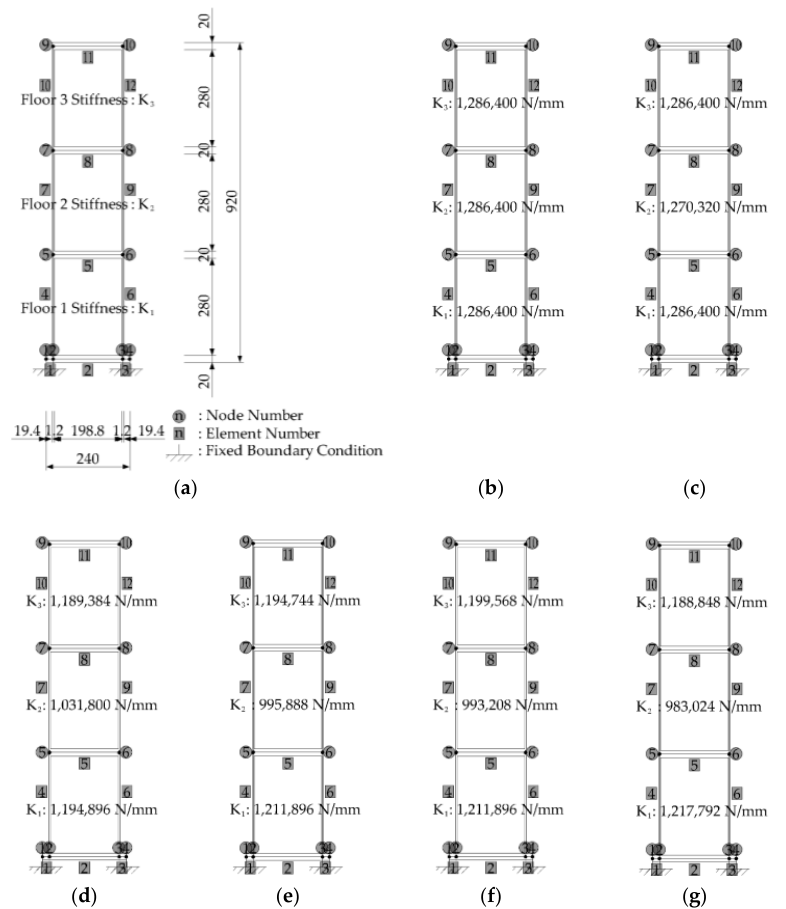
Figure 10. Comparison of the estimated stiffness using different object tracking algorithms: ( a ) FE model, ( b ) column stiffness of design stage, ( c ) damaged column stiffness, and ( d – g ) estimated column stiffness using different tracking algorithms.